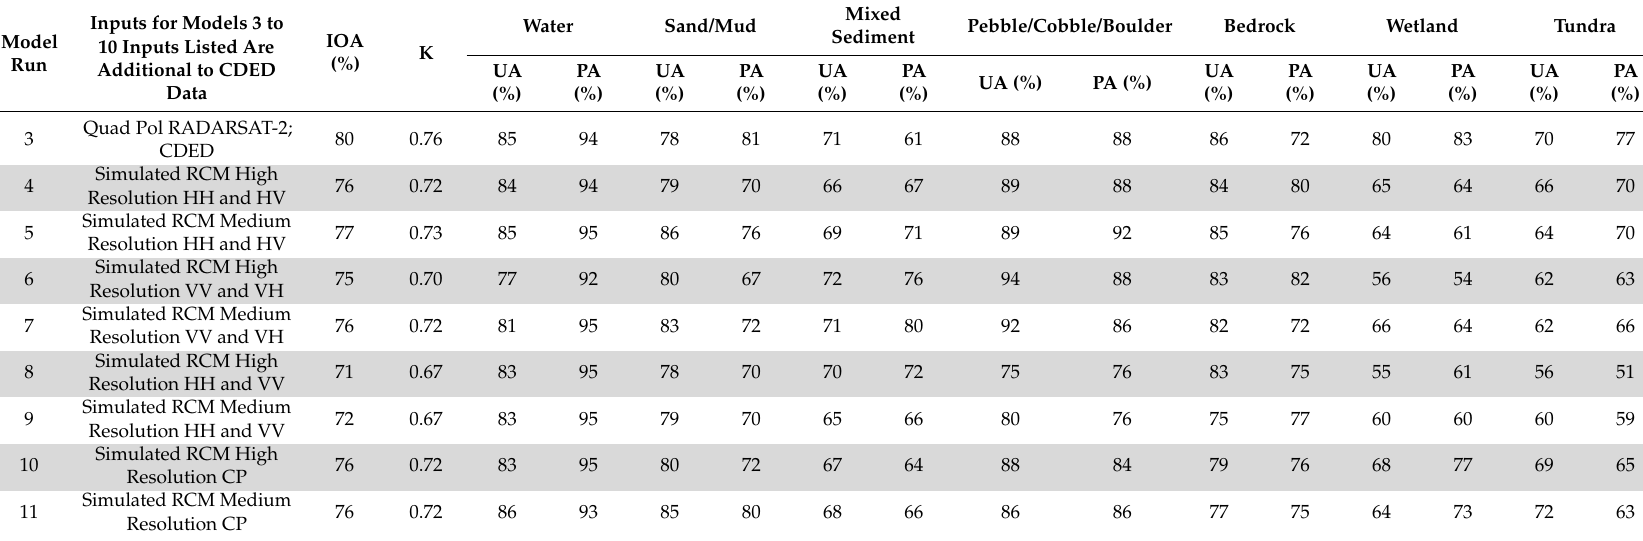
Table 11. Evaluation metrics, including: independent overall accuracy (IOA), Kappa statistic values (K), and per-class user’s and producer’s accuracies (UA and PA) for Random Forest models generated with simulated RCM and CDED data. For comparison, results are included for the Random Forest model based on quad pol RADARSAT-2 and CDED